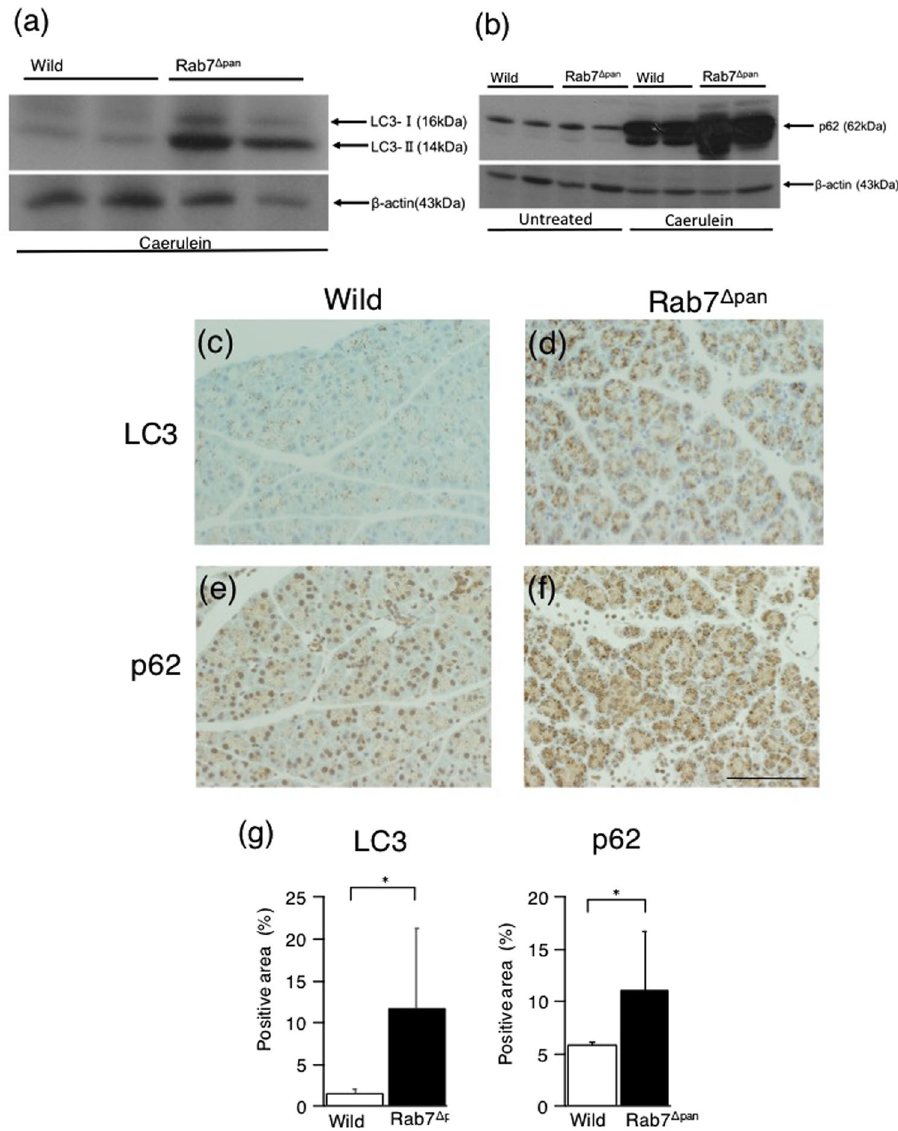
Figure 8. Autophagy in caerulein-induced acute pancreatitis. ( a , b ) WB of LC3 ( a ) and p62 ( b ) using total pancreas homogenates of wild and Rab7 Δ pan mice after ( a ), or before (Untreated) and after (Caerulein) the induction of acute pancreatitis by caerulein ( b ). β -actin was used as an internal loading control. The blots are the representative of two independent experiments with similar results. ( c–f ) IHC of LC3 ( c , d ) and p62 ( e , f ) was performed using wild ( c , e ) and Rab7 Δ pan ( d , f ) mouse pancreases with caerulein-induced acute pancreatitis. Scale Bar: 50 µ m. ( g ) Quantification of the positive signals in images of immunohistochemistry of LC3 (left panel) and p62 (right panel). * P <